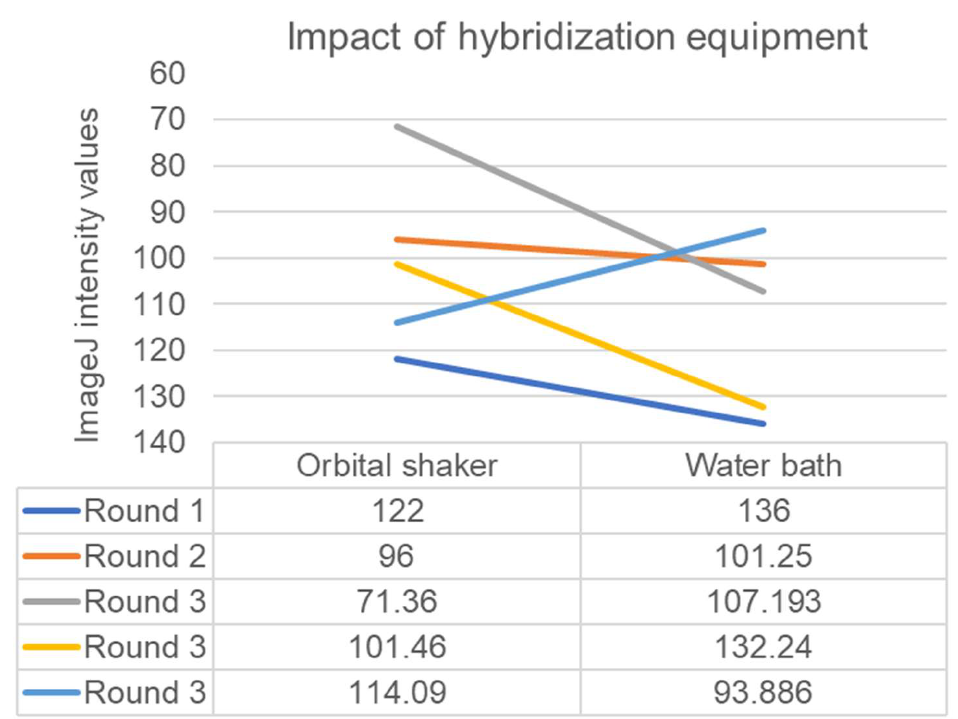
Figure 4. ImageJ intensity values for hybridization steps in orbital shaker versus reciprocal shaking water bath. Signal intensities resulting from the use of an orbital shaker were stronger than those from using a reciprocal shaking water bath in two out of three rounds of probing ( p = 0.07).